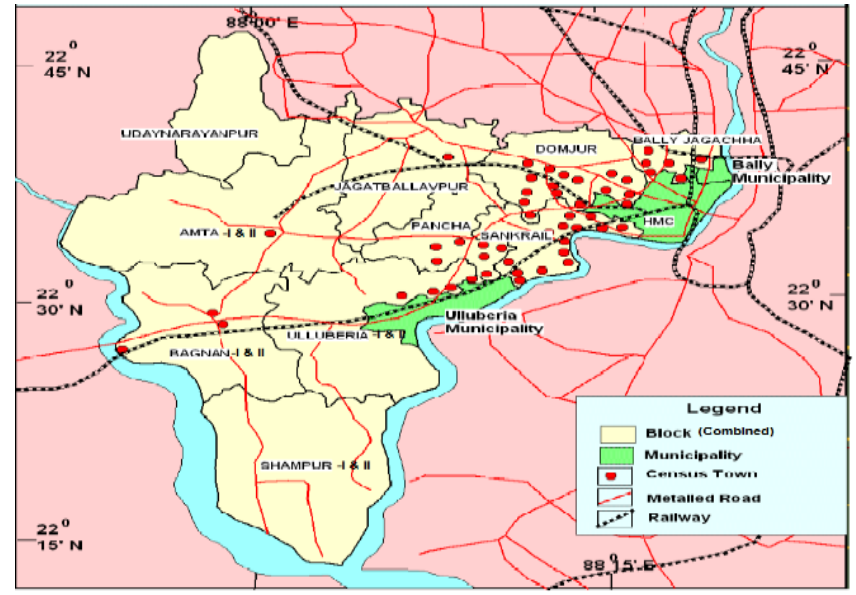
Figure 7. Transport Network of Howrah district. Along with the Census Town.